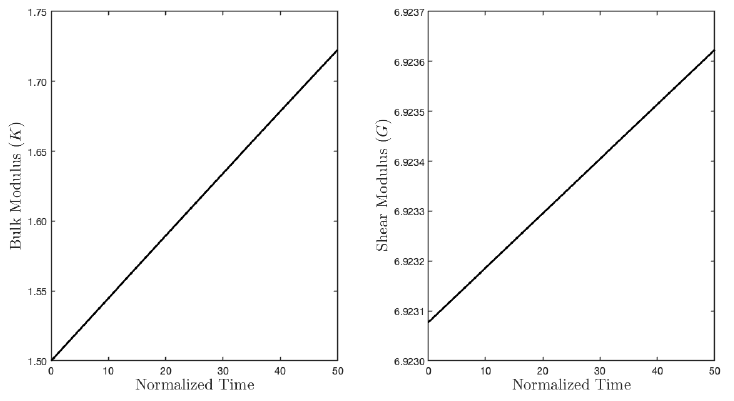
( a ) Evolution of the bulk and shear moduli, expressed in Pa.